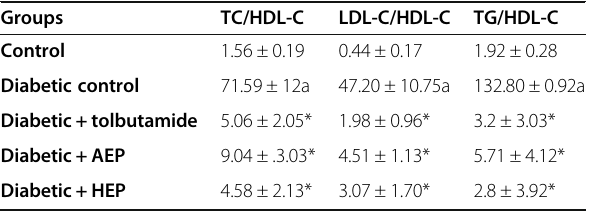
Table 3 Effect of peel extracts of I. Wombolu on the atherogenic risk indices